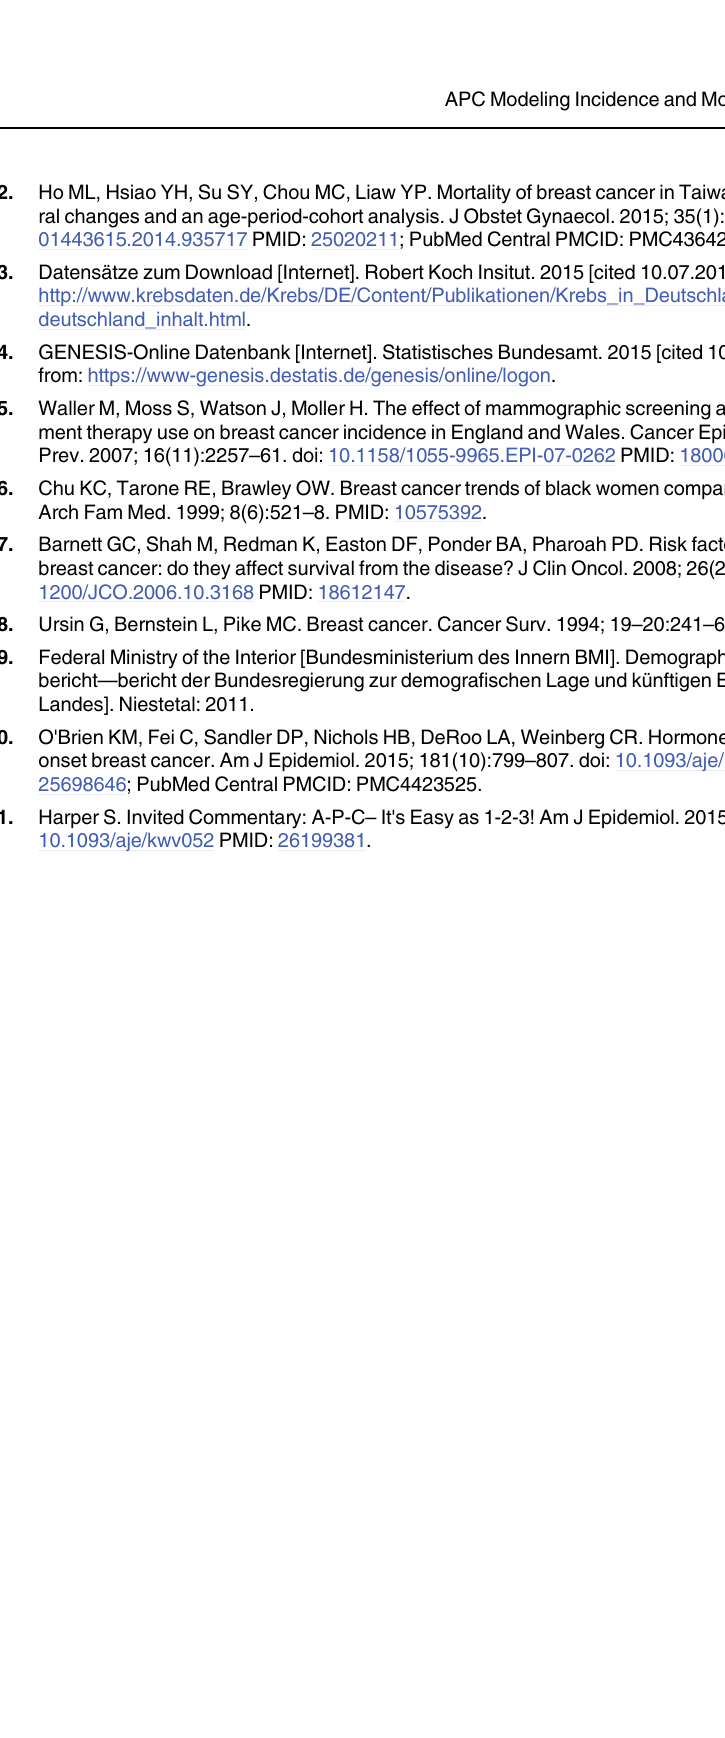
PLOS ONE | DOI:10.1371/journal.pone.0150723 March 2,